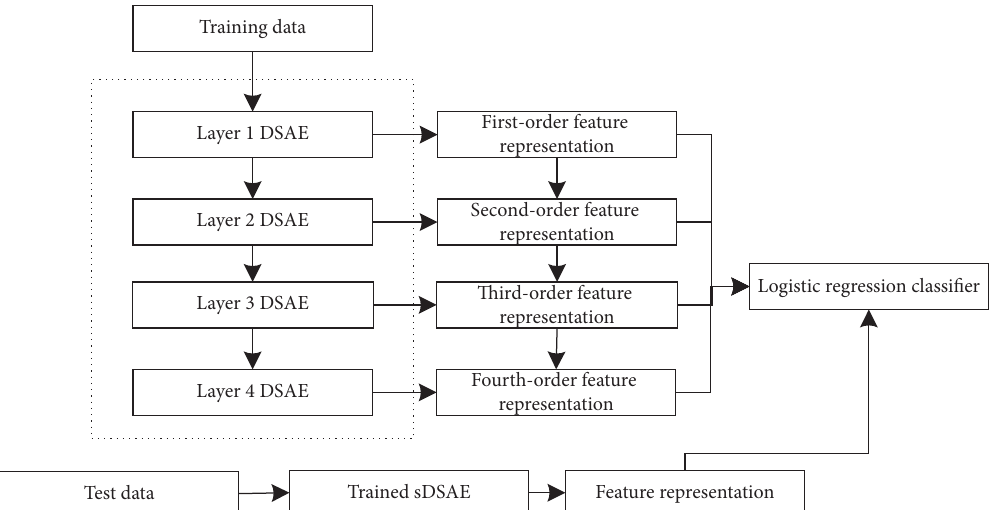
Figure 5: Software defect prediction model structure based on